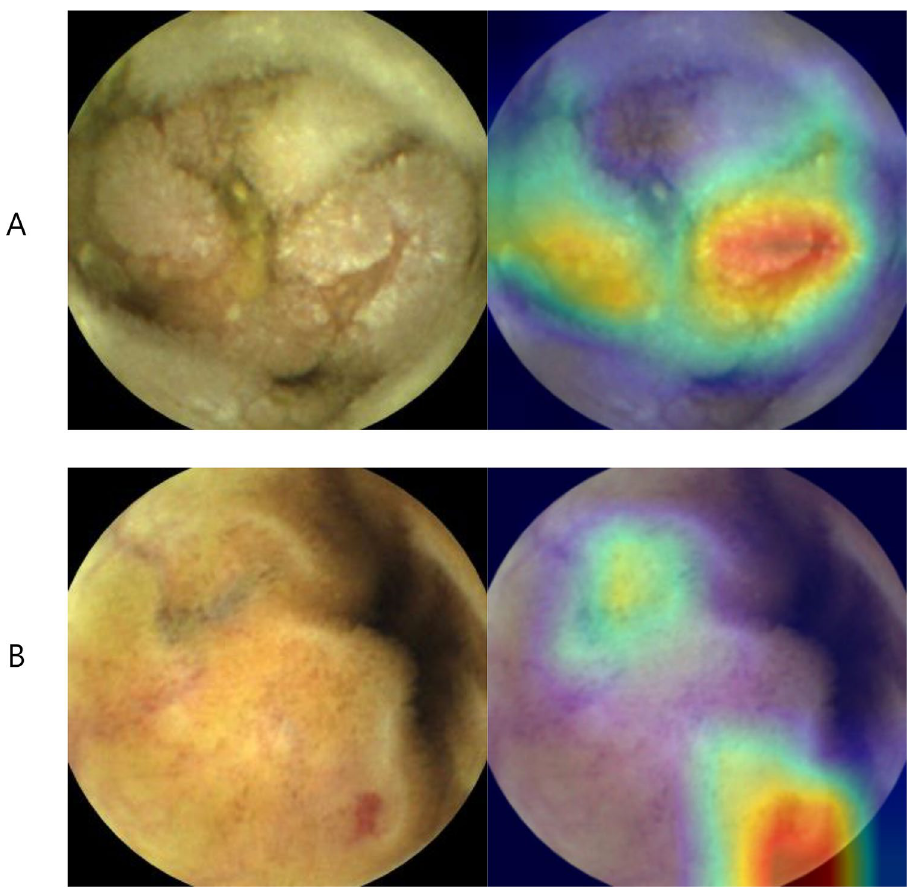
Figure 2. Class activation map of significant lesions. (Capsule endoscopy image taken by Mirocam MC1600, processed by MiroView 4.0—http:// www. intro medic. com/ eng/ main).